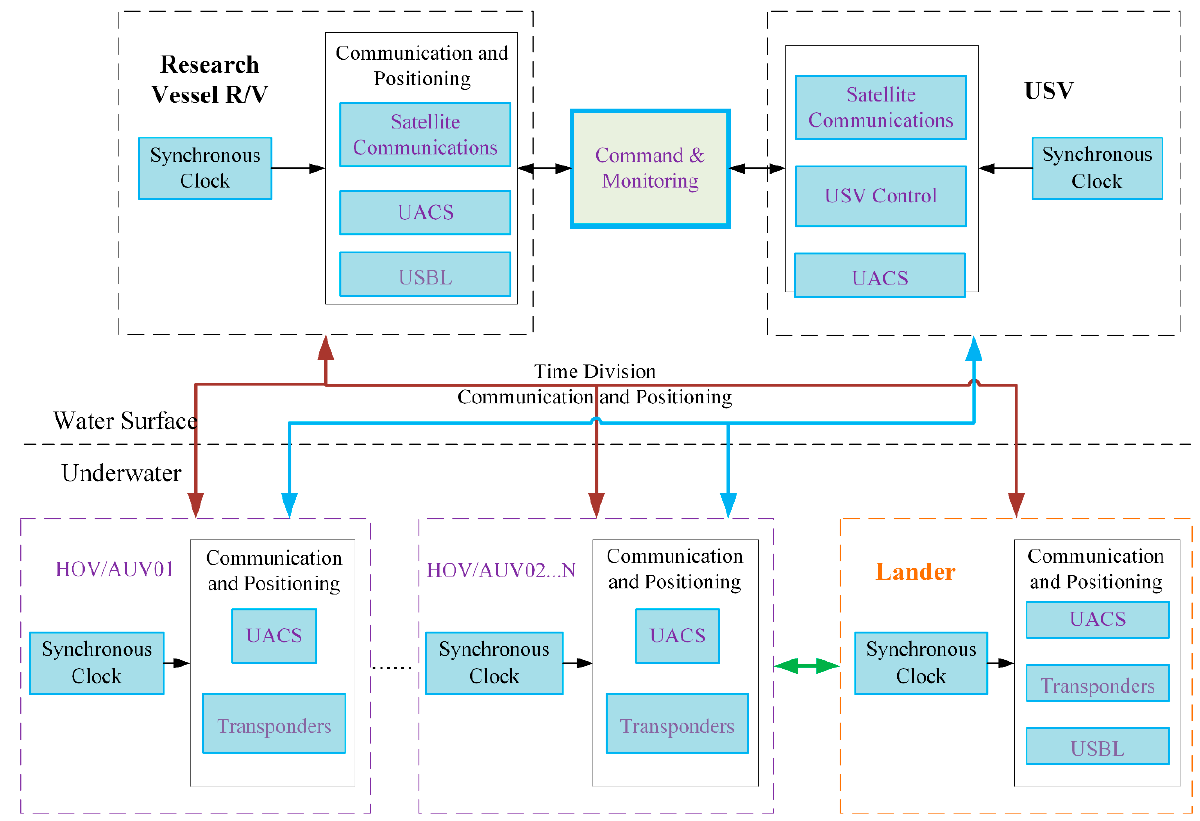
Figure 10. Schematic diagram of the cooperative operational command and monitoring